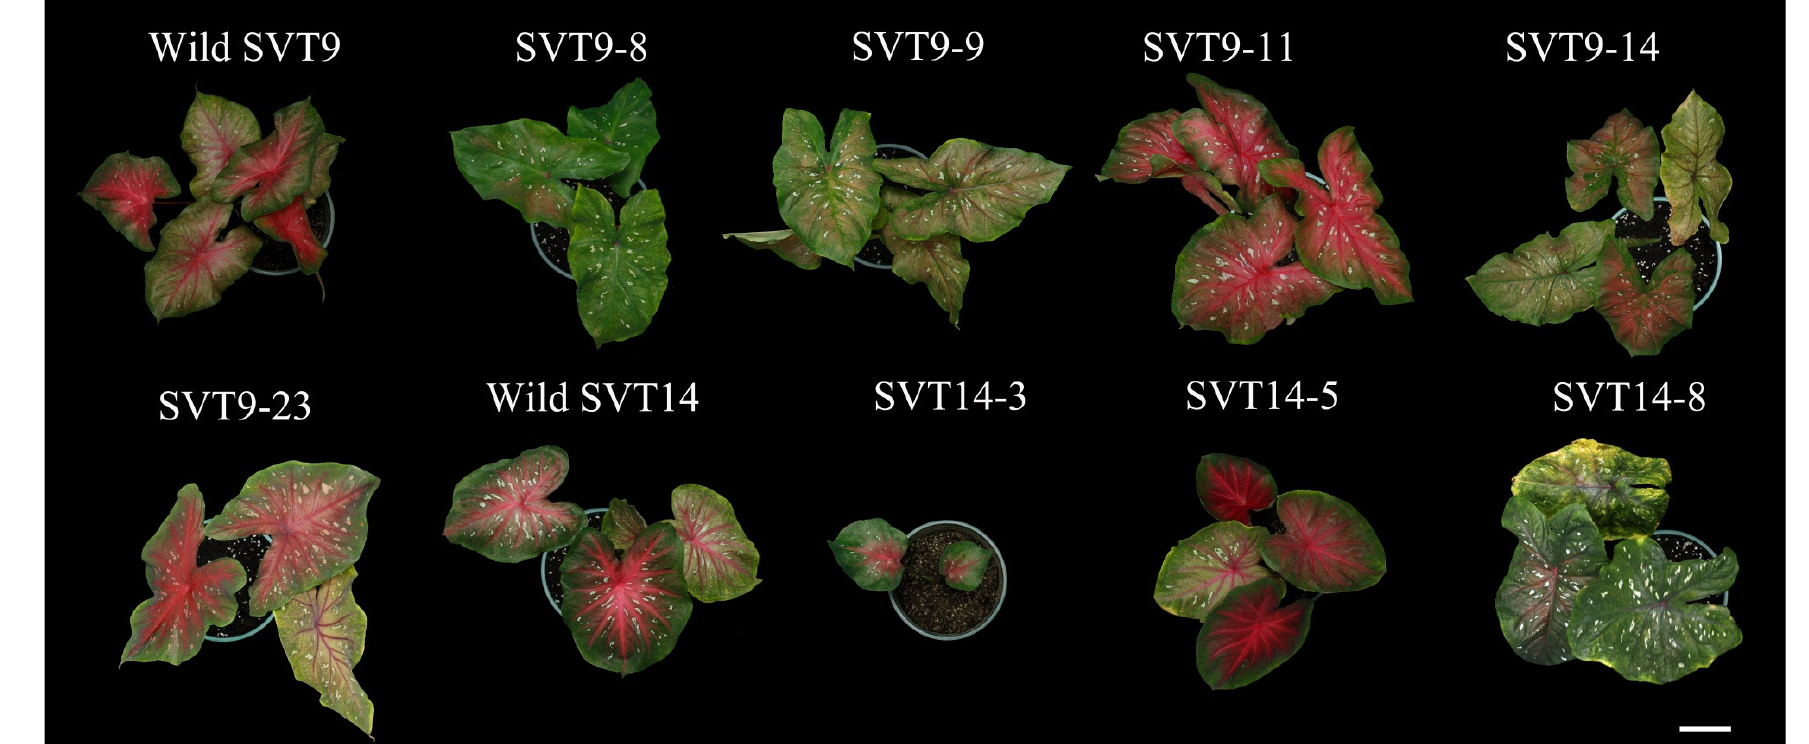
Figure 3. Top views of the variants regenerated from the SVT9 and the SVT14 in vitro and their corresponding wild-type parent after transplantation to the pots for 4 months. Scale bar: 5 cm.